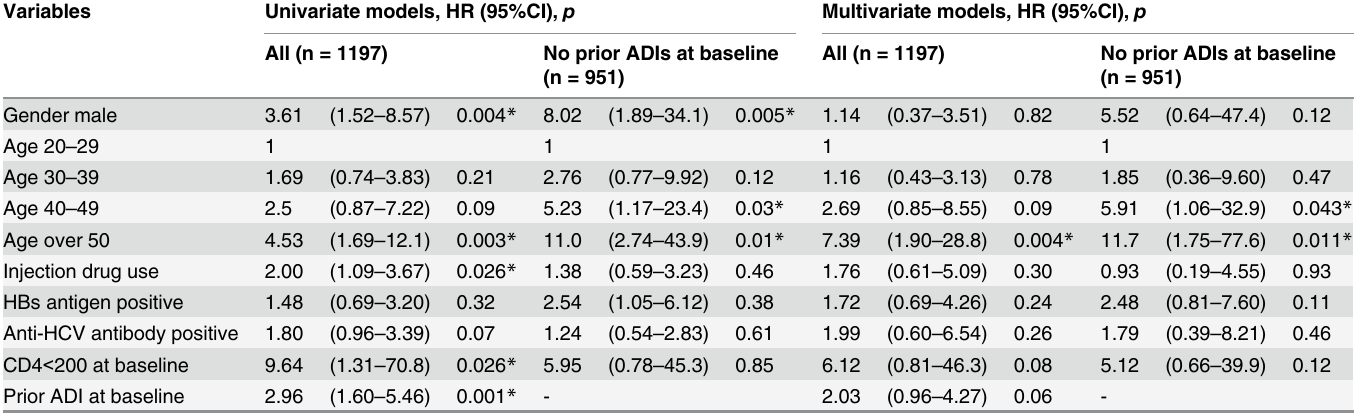
Table 5. Factors Associated with All-Cause